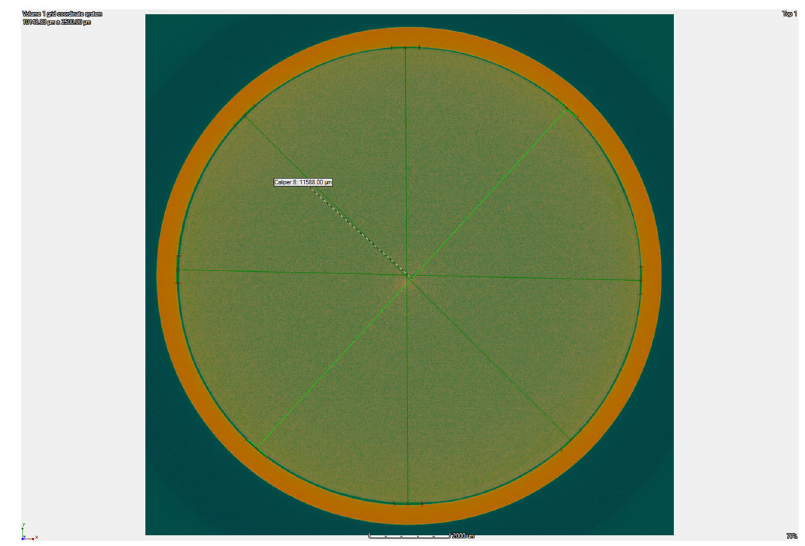
Fig. 8 A typical tube cross-section image. X-ray computer tomography image of a tube